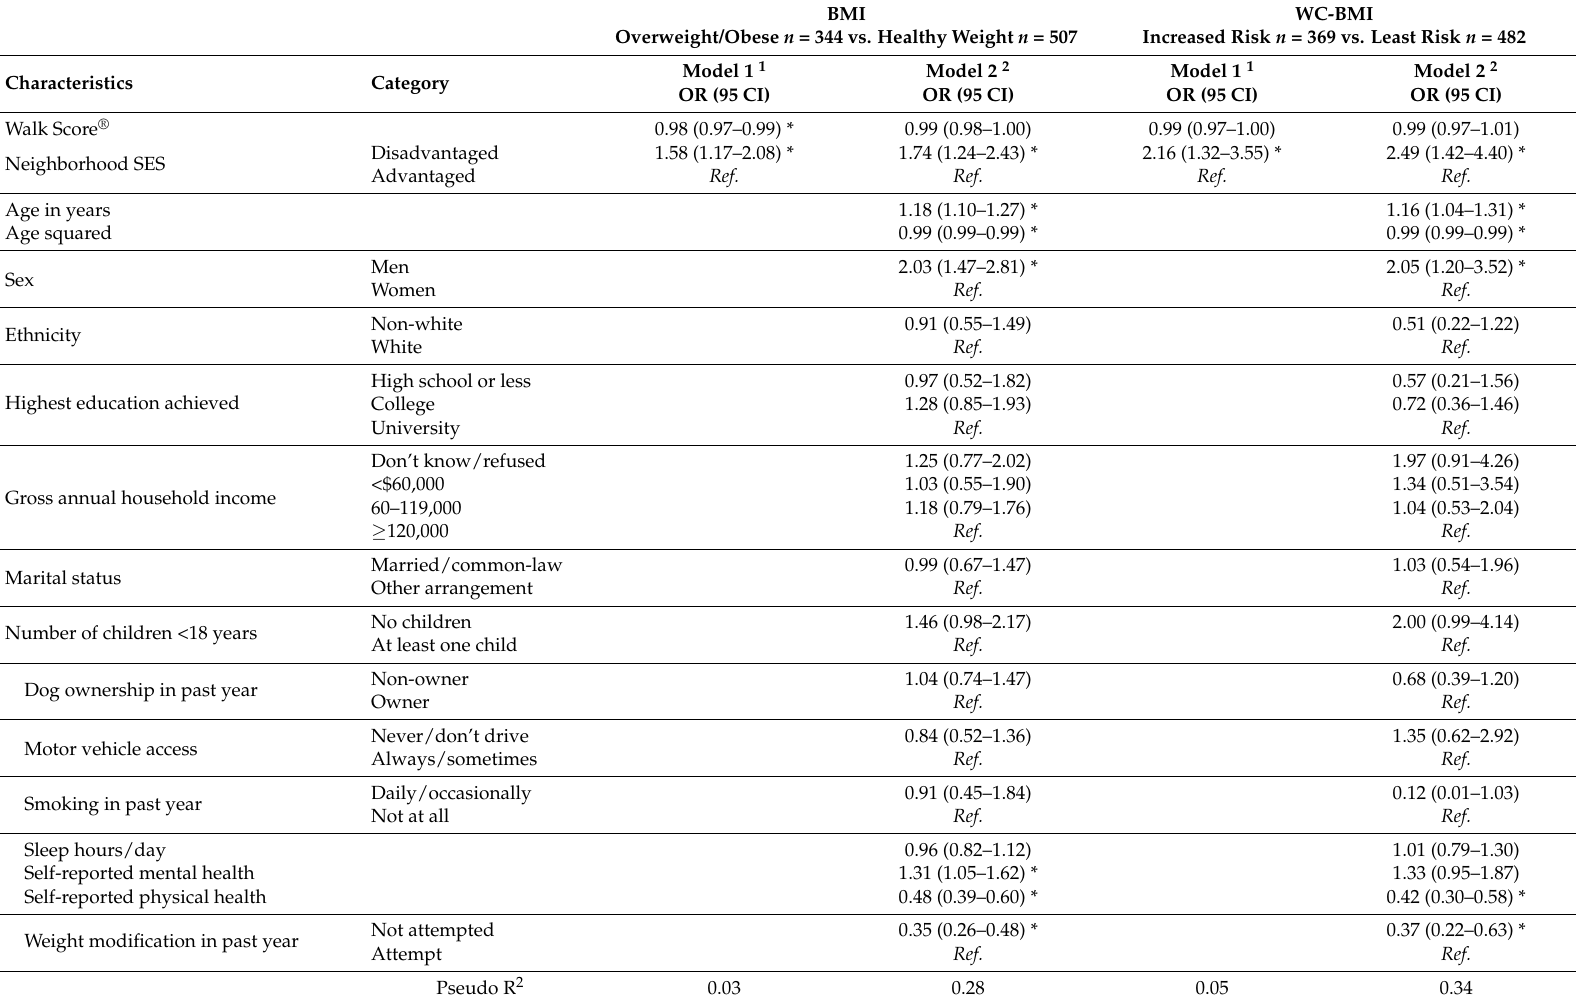
Table 3. Associations between (1) body mass index and (2) waist circumference-body mass index combined, and neighborhood, sociodemographic, and health